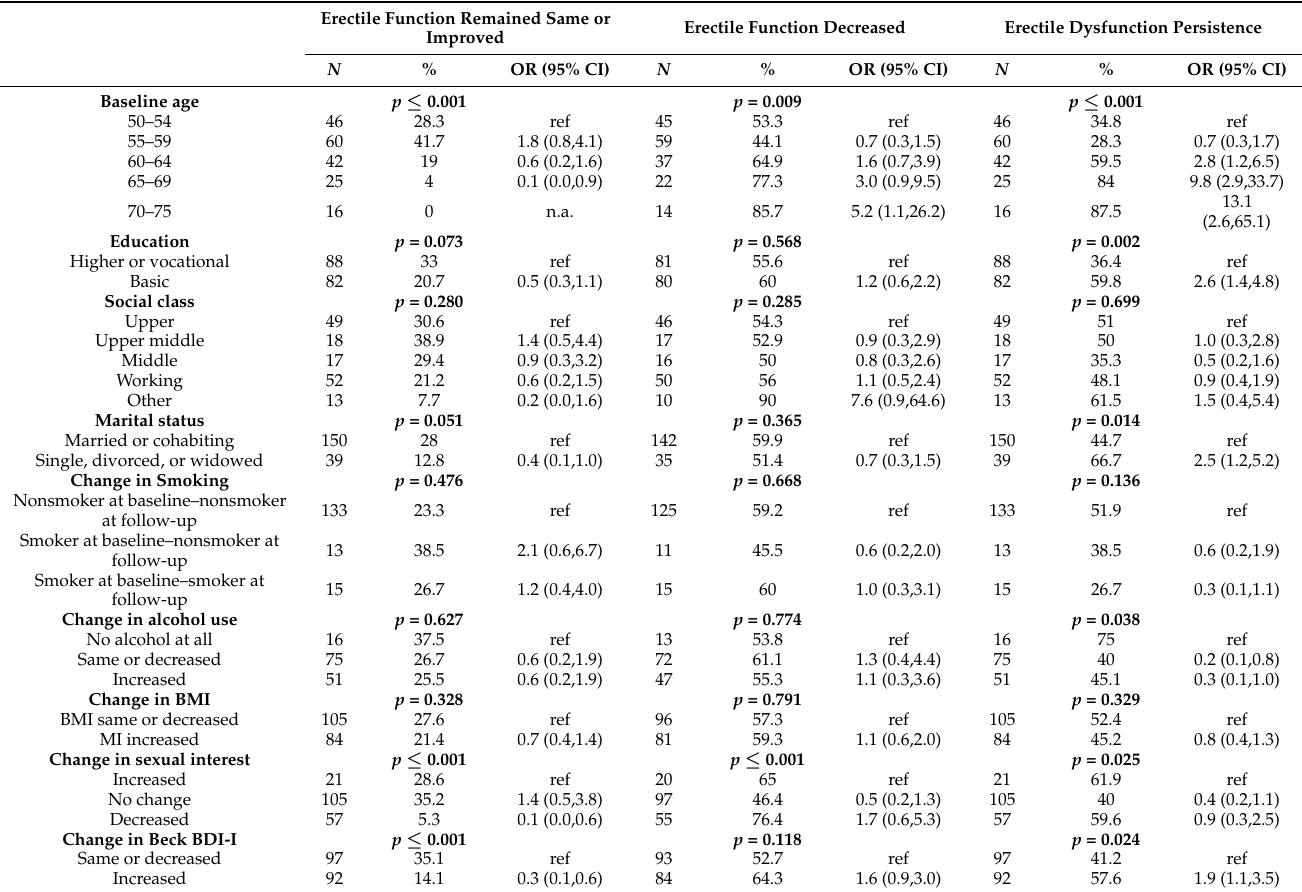
Table 4. Factors which were important in terms of the progression and regression of